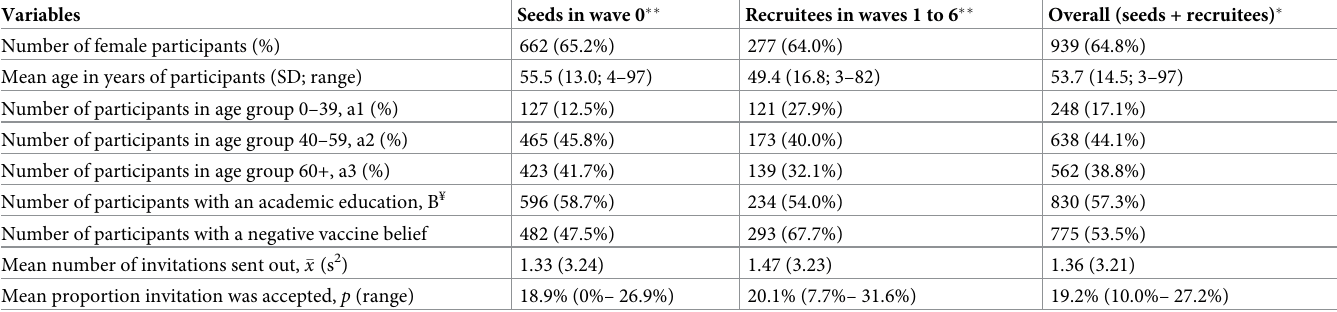
Table 1. Participants’ characteristics and recruitment behaviour as observed during RDD survey in the